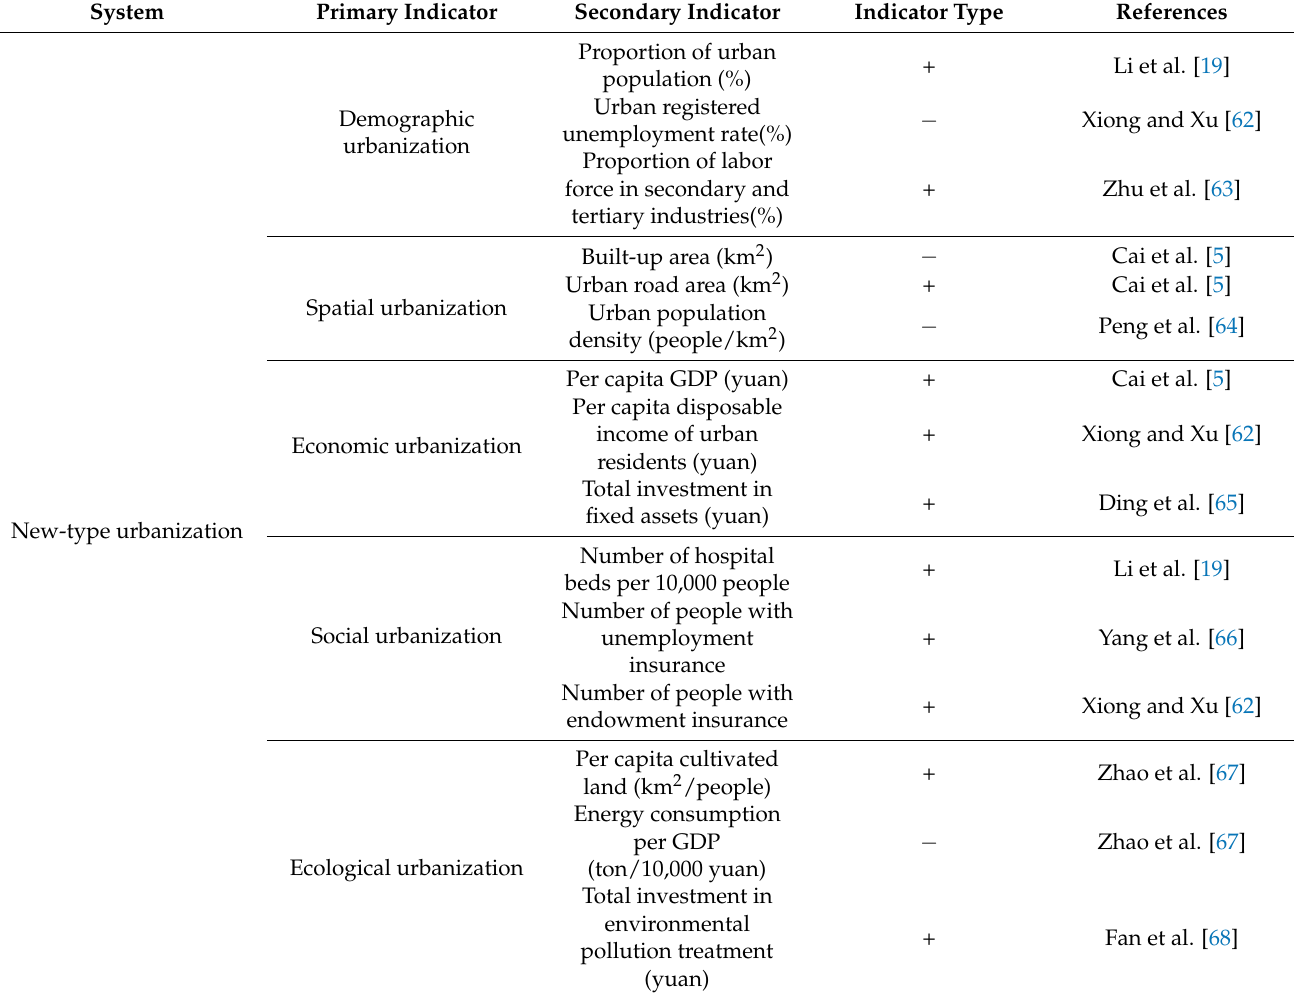
Table 1. Evaluation indicator system of new-type